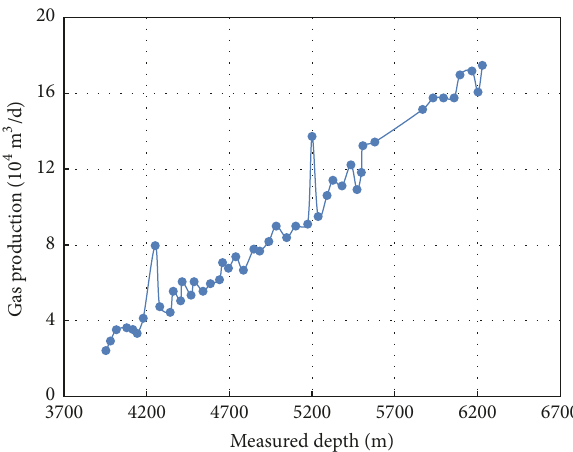
Figure 4: Gas production from a homogeneous sandstone while drilling.